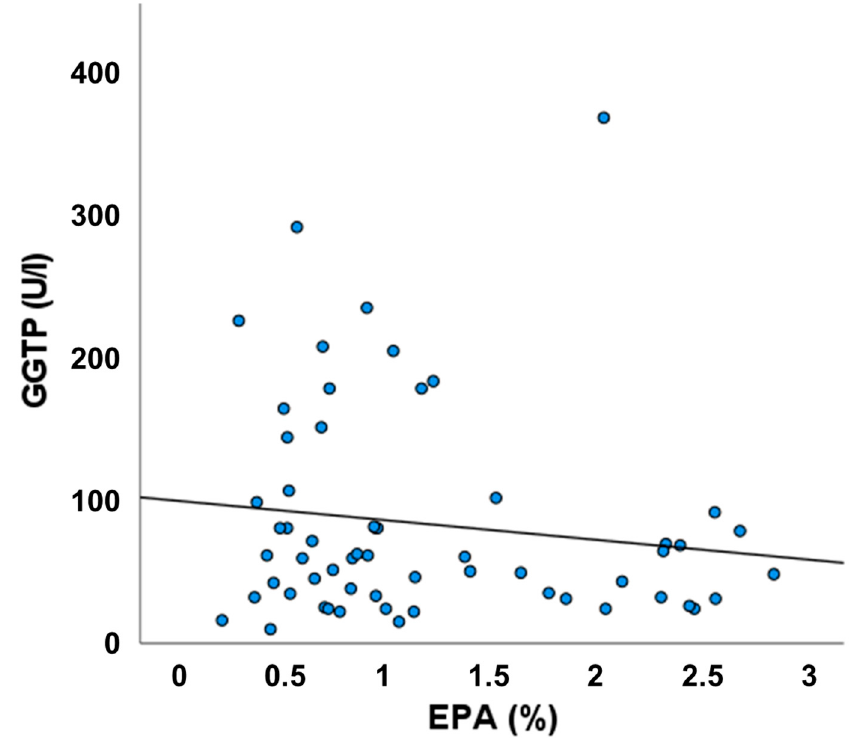
Figure 2. Association between plasma eicosapentaenoic acid (EPA) and GGT. Data are for all patients irrespective of lipid emulsion.